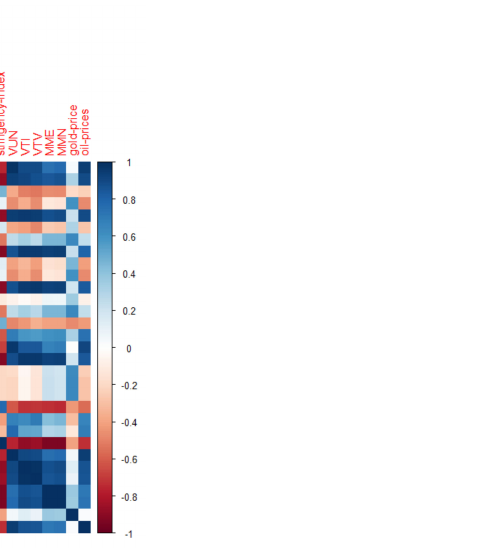
Figure 4. The correlation matrix of the integrated dataset (TC, NC, TD, ND, NT, and TT denotes Total Cases, New Cases, Total Deaths, New Deaths, New Tests, and Total Tests).